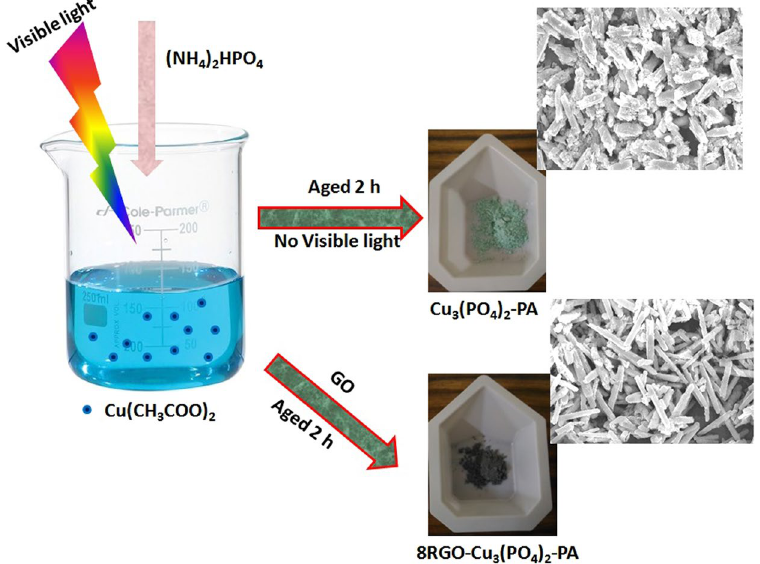
Figure 16. Pictorial representation of Cu 3 (PO 4 ) 2 -PA